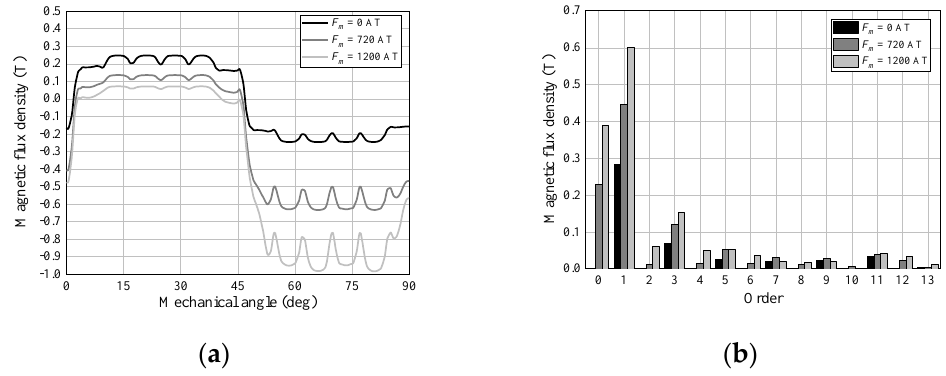
( c ) Figure 6. Vector plot of magnetic flux density: ( a ) PM flux without F m ; ( b ) PM and modulation flux with F m of 720 AT; ( c ) PM and modulation flux with F m of 1200 AT.